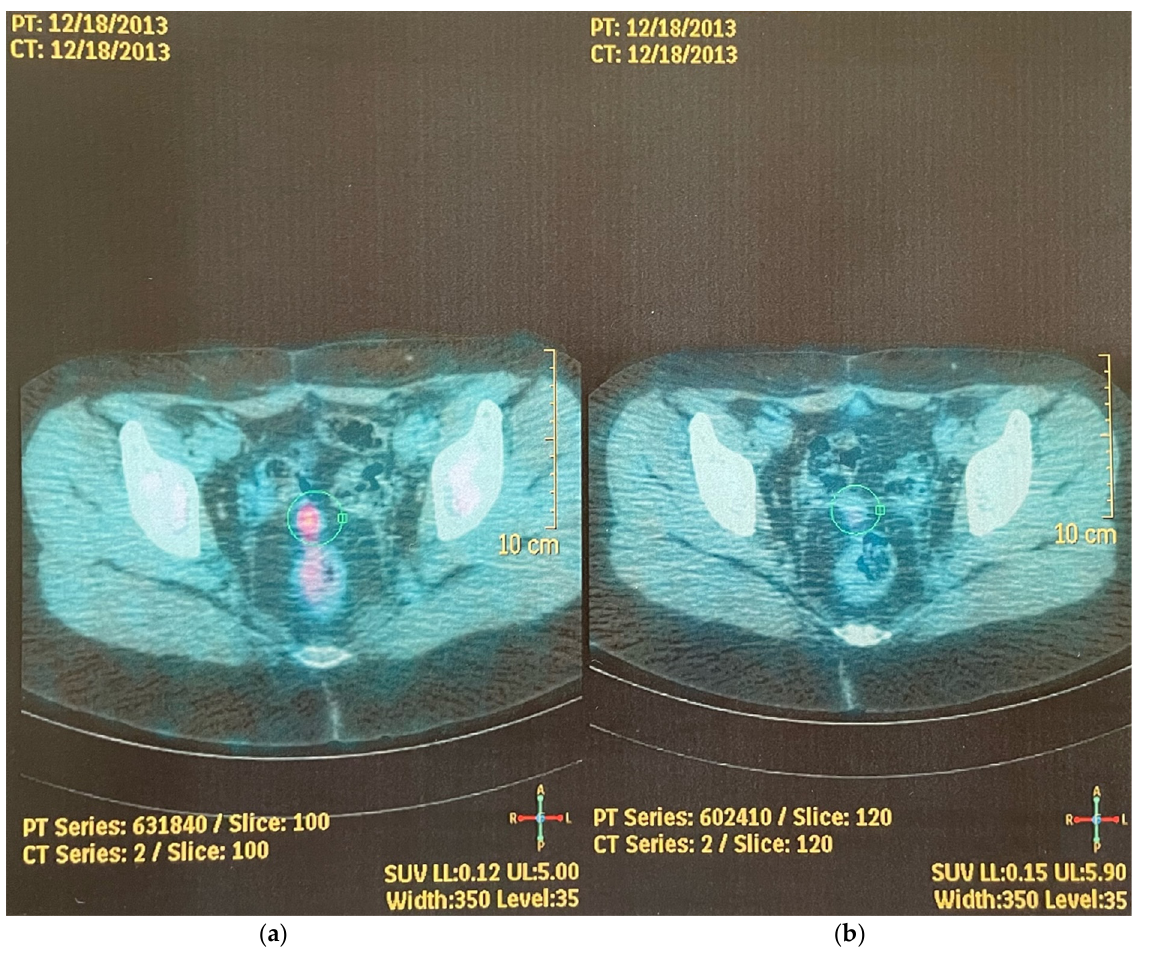
Figure 2. Positron emission tomography. The nodule shown in Figure 1 is further characterized through an FDG PET/TC scan. The middle density nodule found on the axial CT scan ( b ) is shown to be metabolically active (standardized uptake value of 3.7) on an FDG PET ( a ), suggesting the diagnosis of recurrence.